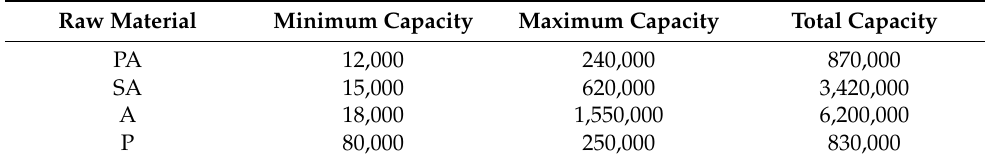
Table 4. Capacity of the suppliers